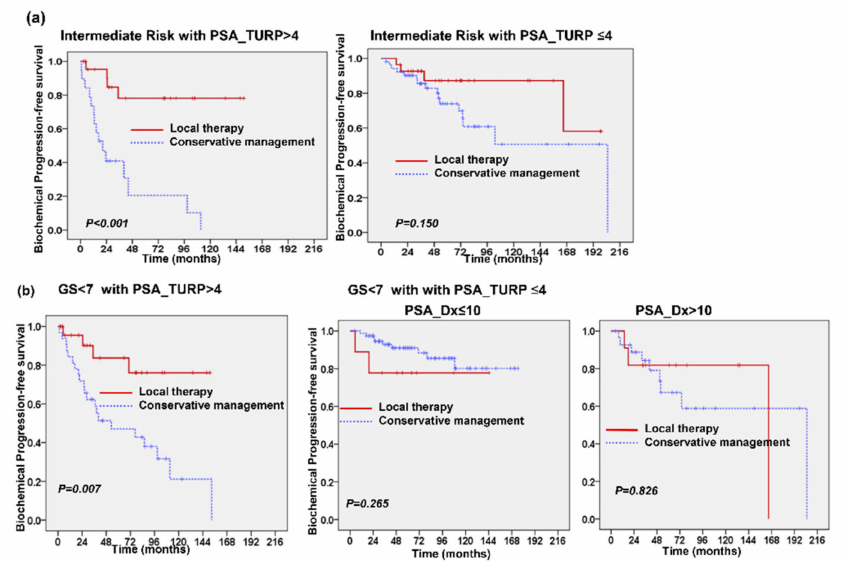
Figure 6. Predictive role of PSA level after TURP in low- and intermediate-risk group. For patients in the intermediate-risk group, local therapy significantly improved the prognosis for patients with high PSA_TURP but not for patients with PSA_TURP ≤ 4 ng/mL ( a ). For patients with GS < 7, local therapy significantly improved the prognosis for patients with high PSA_TURP but not for patients with PSA_TURP ≤ 4 ng/mL regardless of pre-TURP PSA ≤ 10 or >10 ng/mL ( b